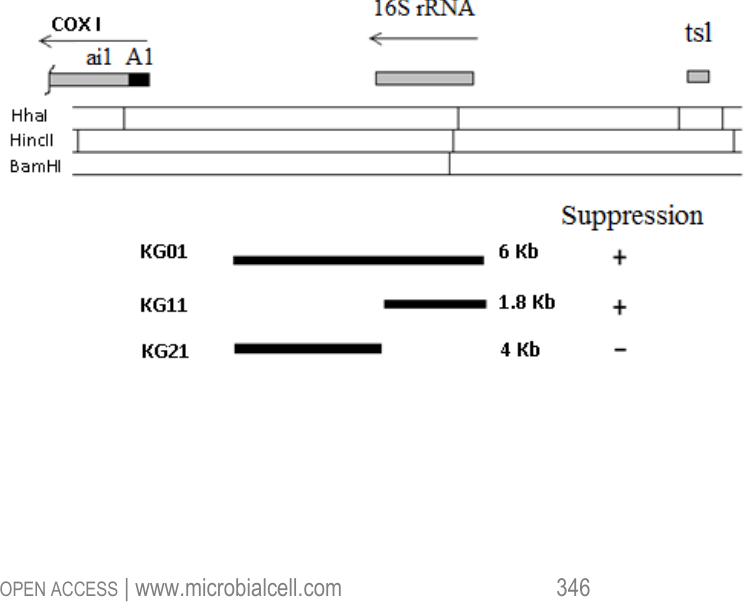
FIGURE 2: Physical mapping of the mim3-1 suppressor. The restriction map and position of 15s rRNA and COX1 (subunit I of cytochrome oxidase) genes are shown at the top. tsl: locus involved in tRNA maturation. The KG01 rho - petite, carrying the mim3-1 mutation, was sub- jected to ethidium bromide mutagenesis and sub-cloned twice in the absence of the drug. A few hundred colonies were tested for suppres- sion of the M3041 target mutation. + and - indi- cates suppression or its absence. Most of the sub-clones did not suppress any longer; 24 rho - sub-clones were further analysed by restriction (only a few sites are shown) and blotting with a probe constituted by the KG01 mitochondrial DNA. The lengths and positions of tandem re- peats retained in mtDNA of three discriminating petites are represented by thick bars indicating that the suppressor is located in the 15s rRNA